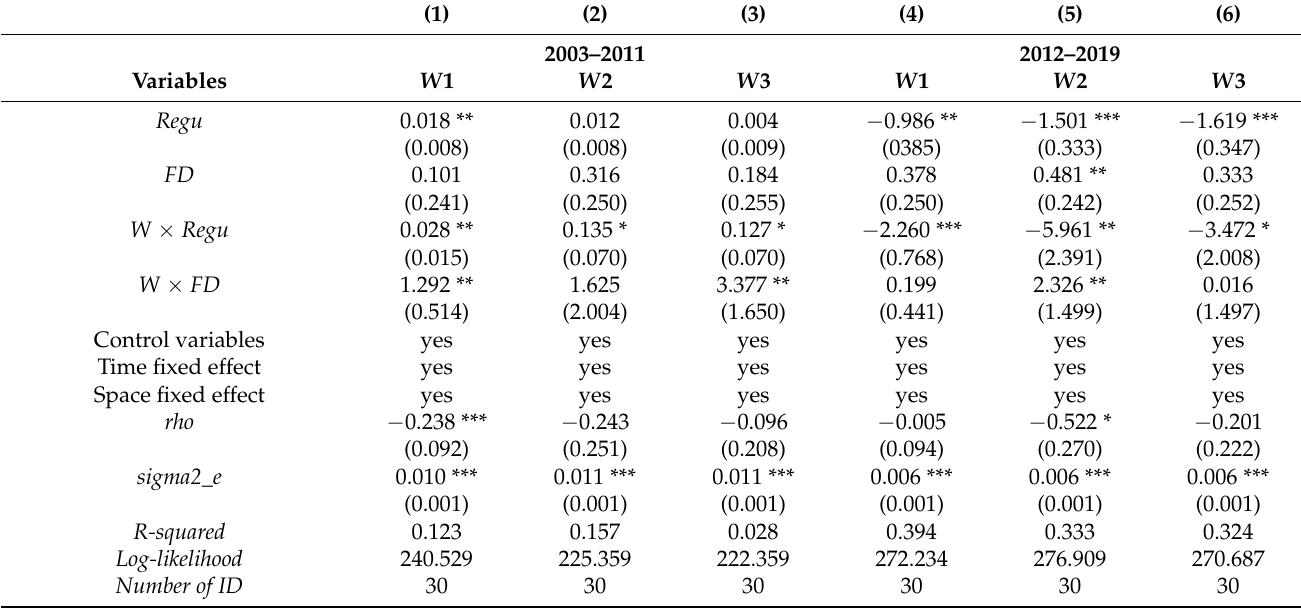
Table 14. Regression results of the impact of environmental regulation competition on carbon emissions by